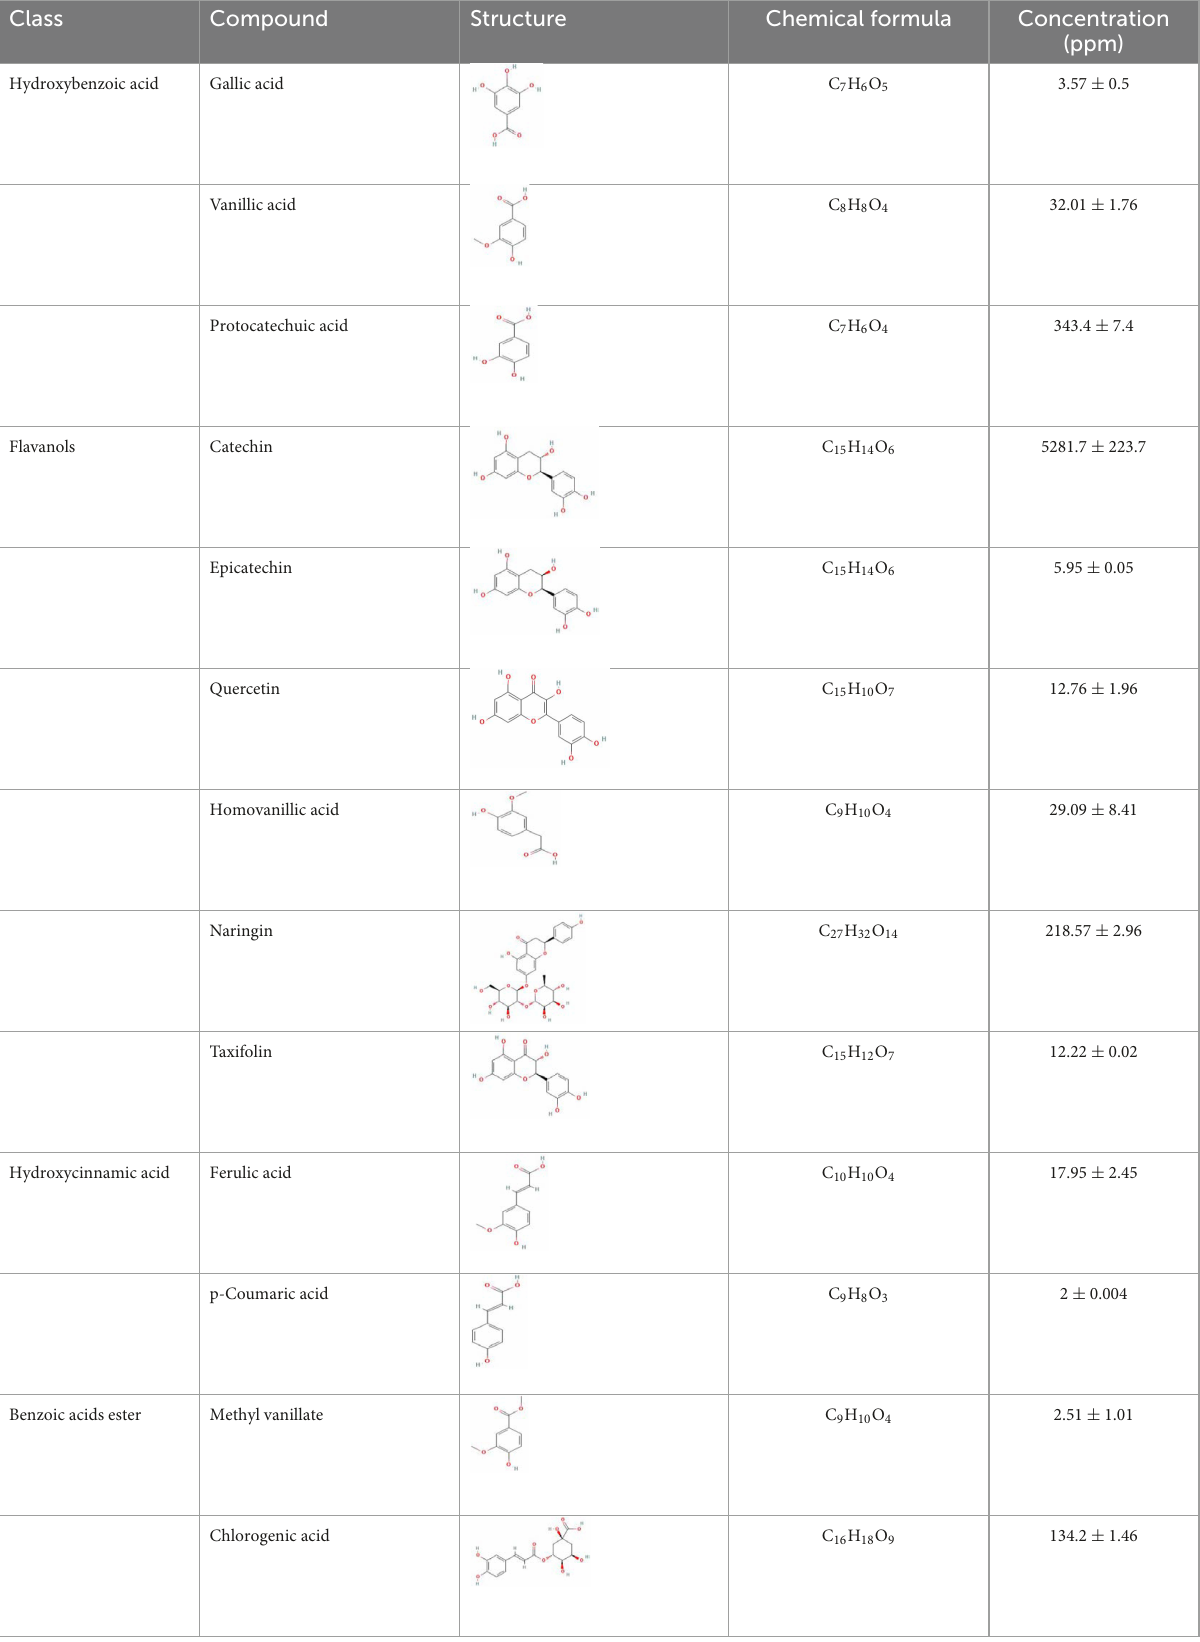
TABLE 1 Various polyphenolic compounds present in finger millet extract (n-hexane)